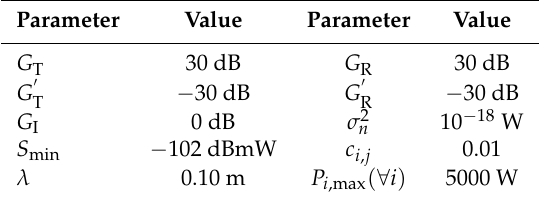
Table 1. Coexisting DMRS and Wireless Communication System